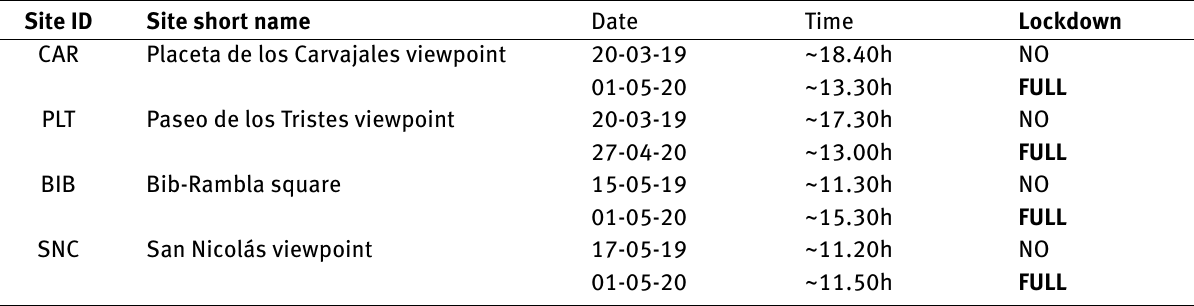
Table 2: Sound recordings date, time and lockdown conditions Site